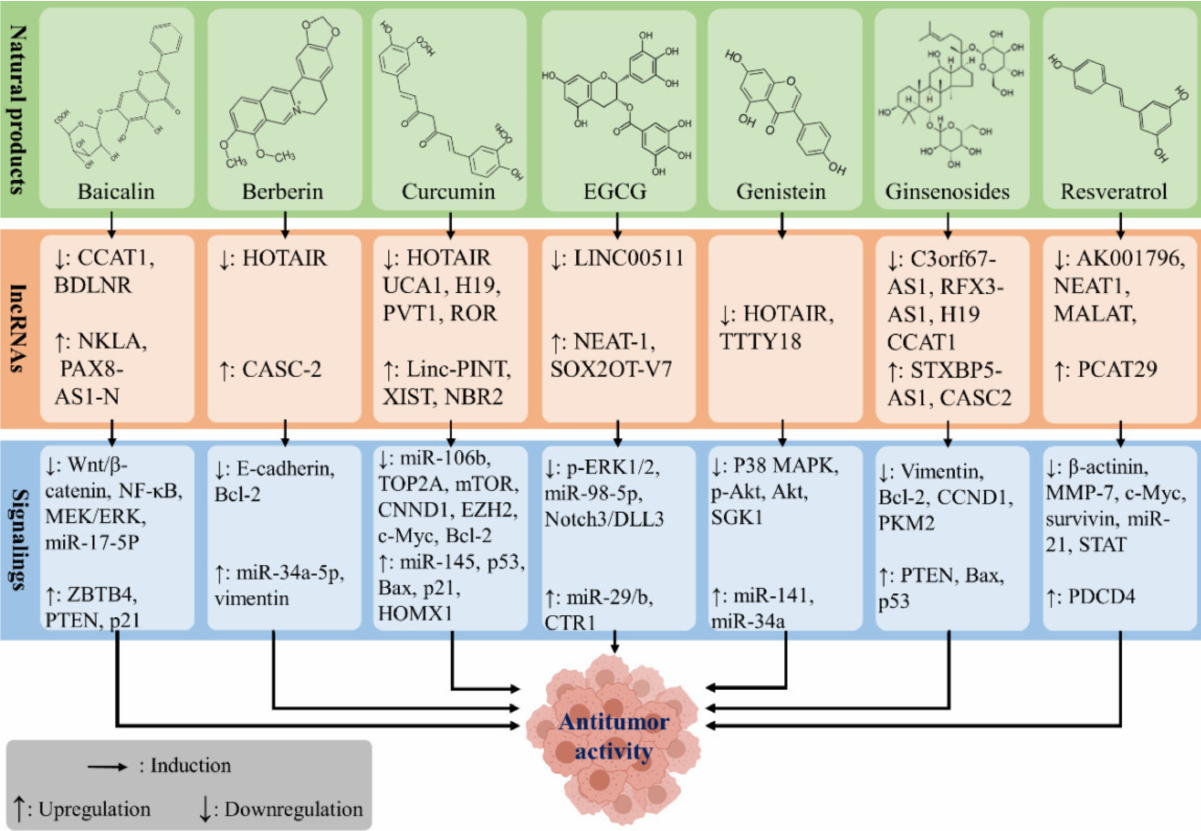
Figure 4. The potential anticancer effect of phytochemicals via regulation of the expression of